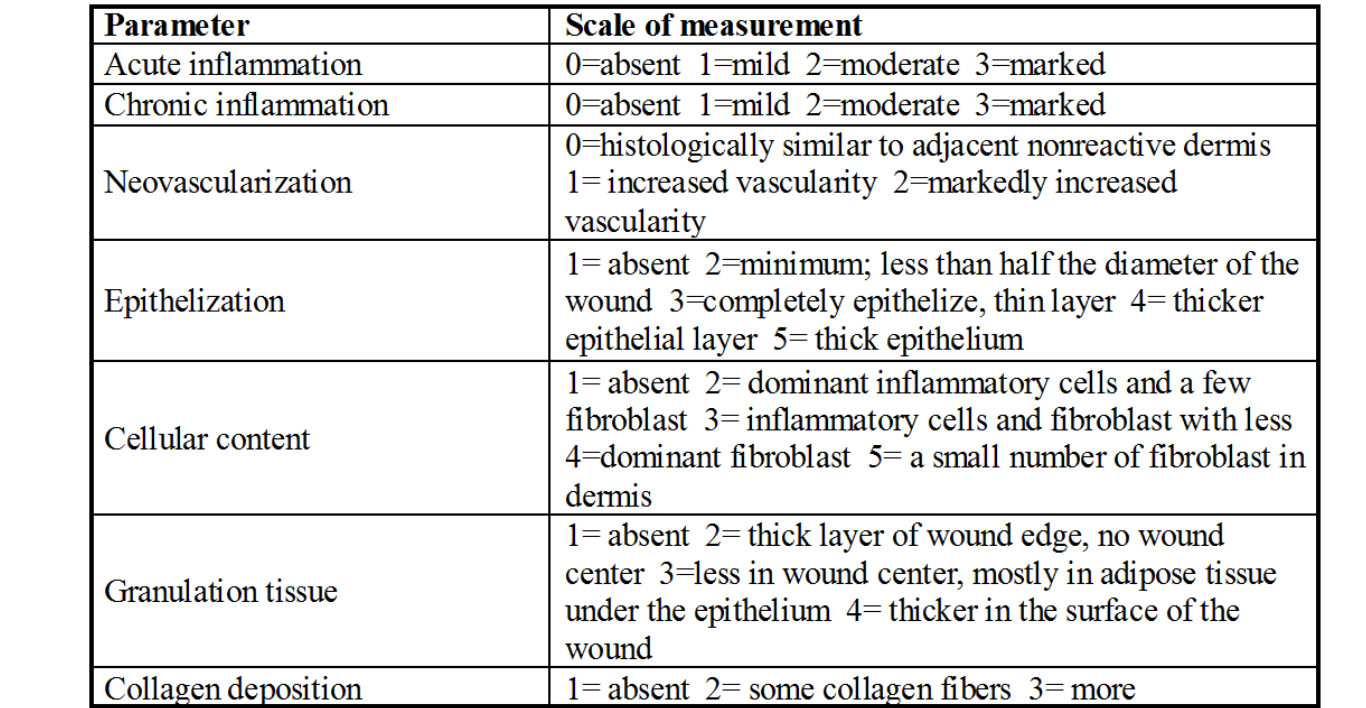
(Table I). Two investigators independently scored the histopathology of the